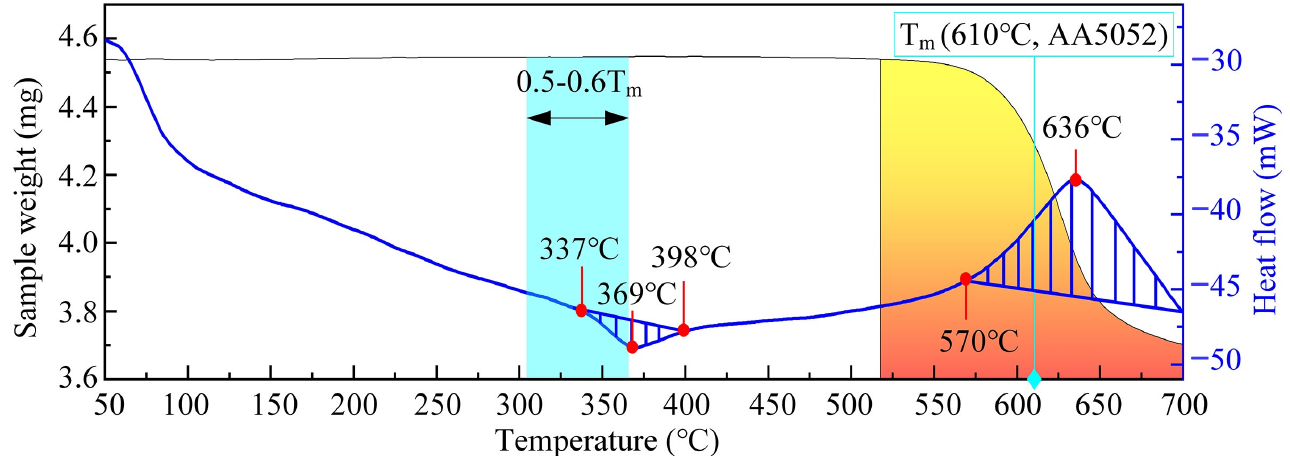
Figure 14. Thermal characteristics of CF-PEEK. Reprinted with permission from Ref [84]. 2021, H. Dong, Z. Tang, P. Li et al.